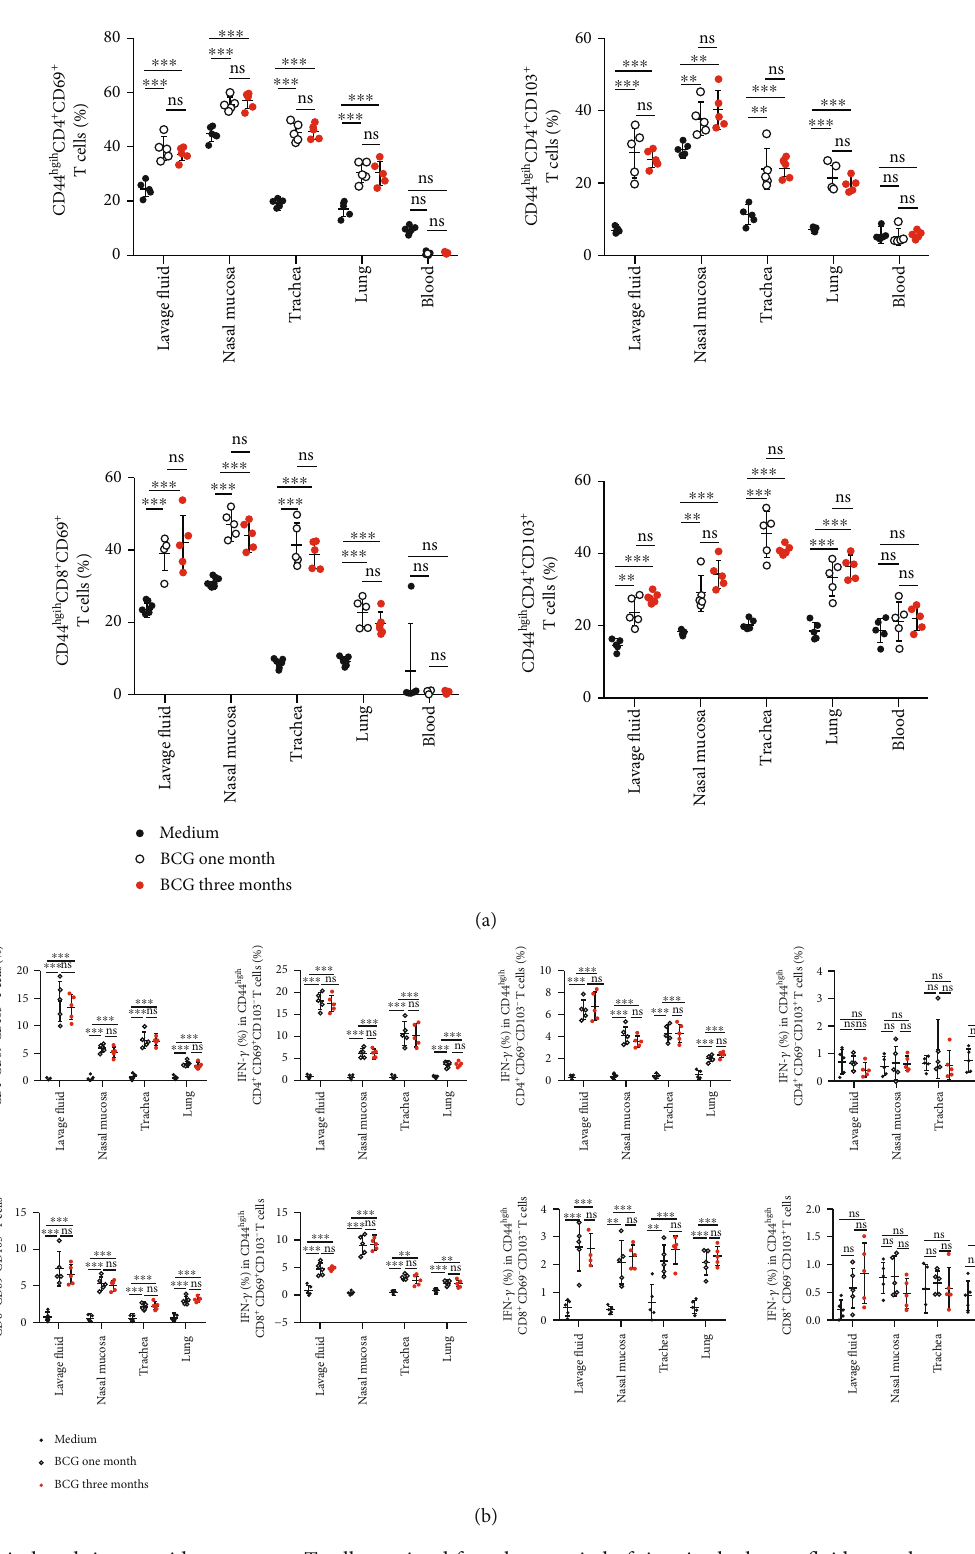
Figure 7: BCG-induced tissue-resident memory T cells persisted for a long period of time in the lavage fl uids, nasal mucosa, trachea, and lungs. (a, b) ( n = 5 ) After intranasal vaccination of mice with BCG for one and three months, the proportion of CD44 high CD4 + CD69 + , CD44 high CD4 + CD103 + , CD44 high CD8 + CD69 + , and CD44 high CD8 + CD103 + T cells and the expression of antigen speci fi c IFN- γ in the four groups of CD69 − /+ CD103 − /+ T cells on CD4 + and CD8 + T cells were analyzed as mean ± SEM . The results representing four independent experiments for fi ve mice each group were shown and compared with two-way ANOVA. ∗∗ P < 0 : 01 and ∗∗∗ P < 0 : 001 ; ns: no signi fi